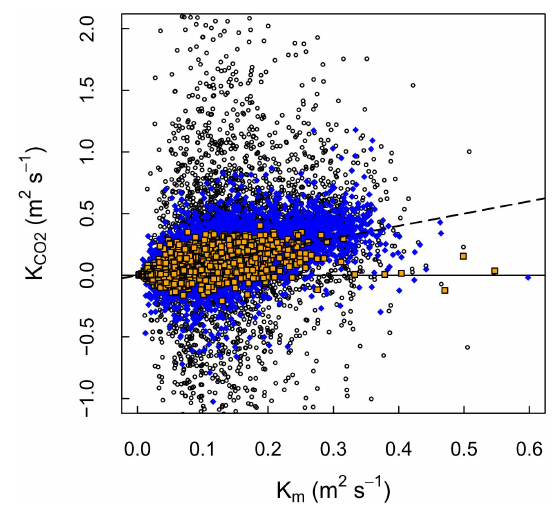
Figure 4. Half-hourly values of the turbulent diffusivity of CO 2 (from gradient measurements with the FTIR and flux measure- ments by eddy covariance) vs. the diffusivity of momentum for neu- tral stratification (from sonic anemometer data), for the IFR site. Open circles: no filtering of (cid:49) [CO 2 ] (mole-fraction difference be- tween intake heights), solid diamonds: (cid:49) [CO 2 ]<0.6ppm excluded, framed squares: (cid:49) [CO 2 ]<2.4ppm excluded. The dashed line is the 1 : 1